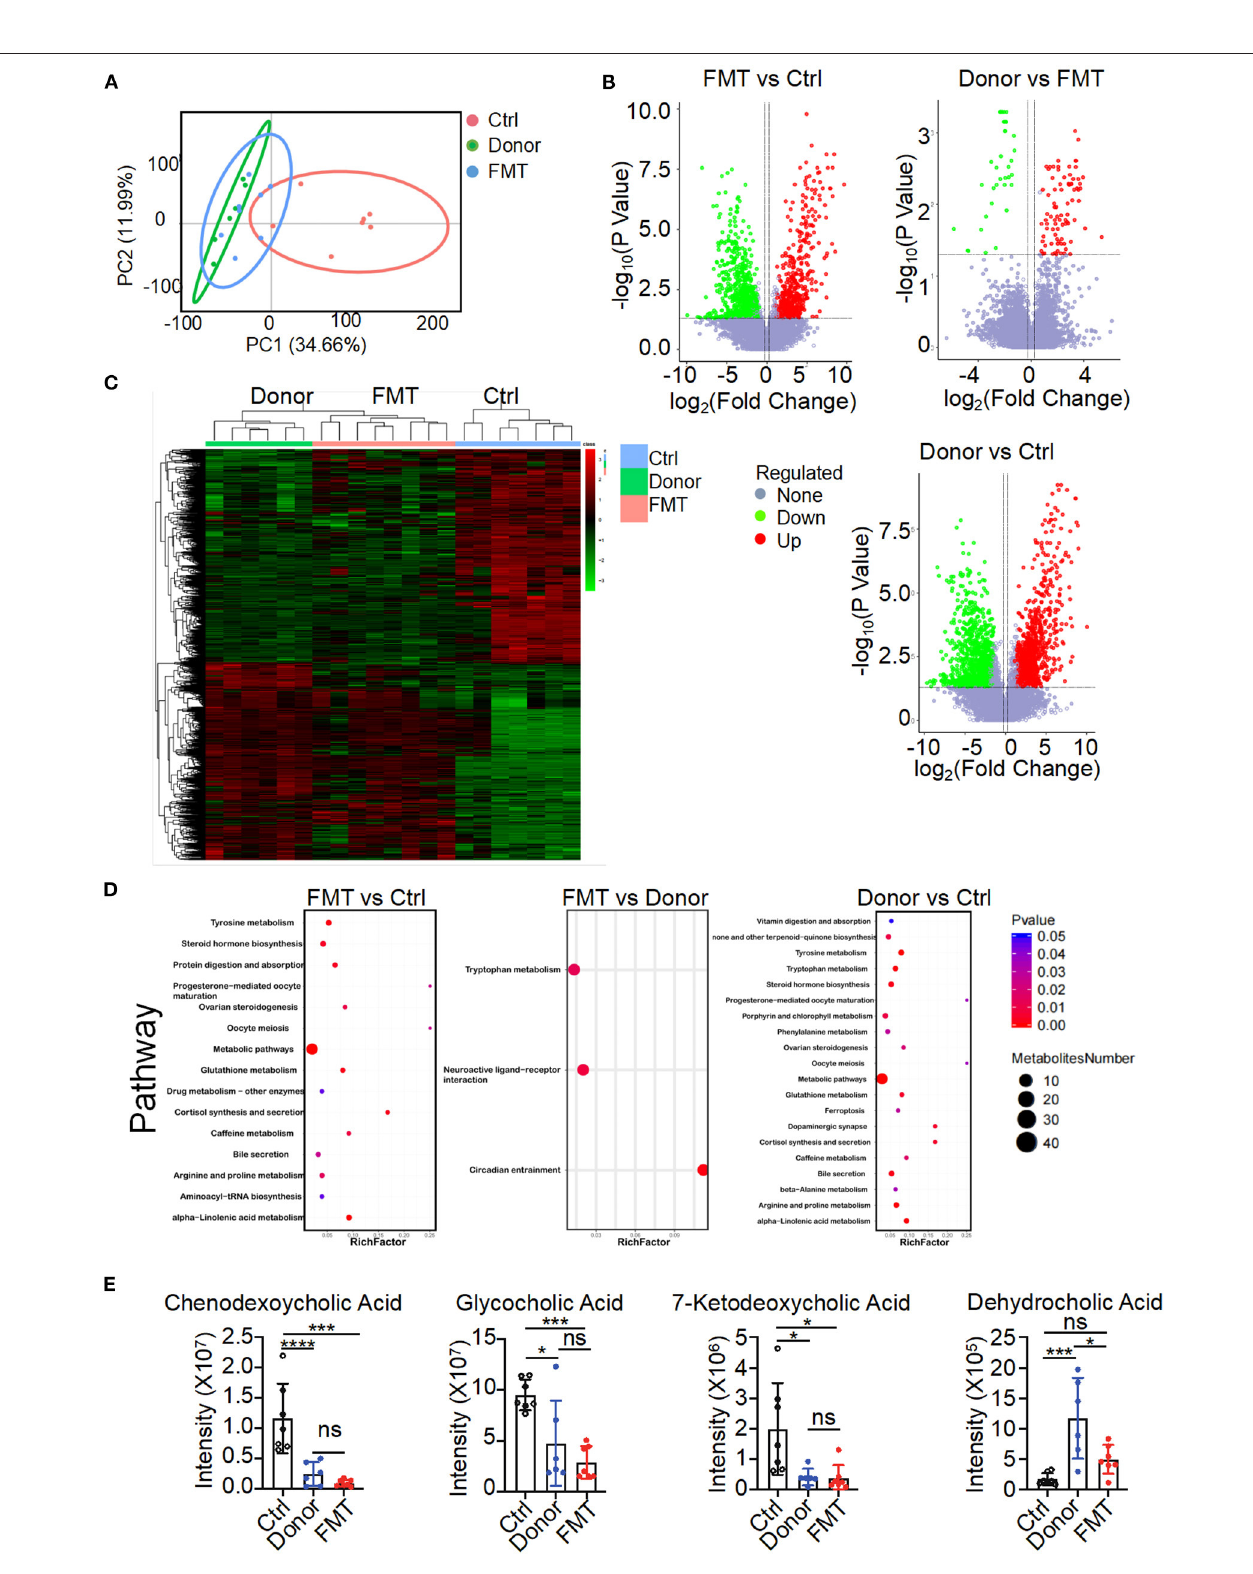
FIGURE 5 | Altered gut microbial-associated metabolite profiles in the FMT group. (A) PCoA analysis of fecal metabolomes from the donor, FMT, and control groups ( n = 6–7). (B) Volcano plots of differential gene expression: FMT vs. control, donor vs. FMT, donor vs. control groups. (C) Heat map of fecal metabolites composition in the donor, FMT, and control groups. Each column represented a single mouse. Red, overrepresented bacterial genes; green, underrepresented bacterial genes.